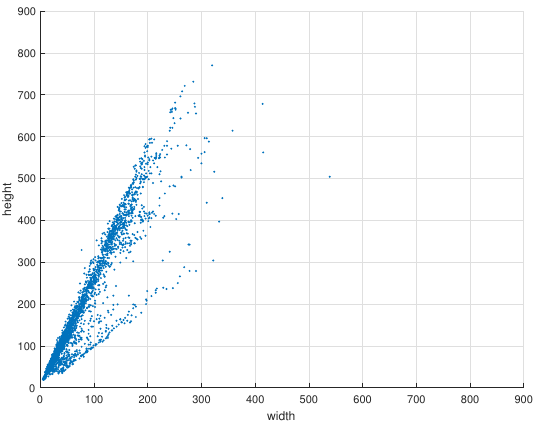
Figure 6. The distribution of cyclist instances in test set. The x-axis and y-axis represent the width and height of the ground-truth in pixels. One blue point represents one cyclist